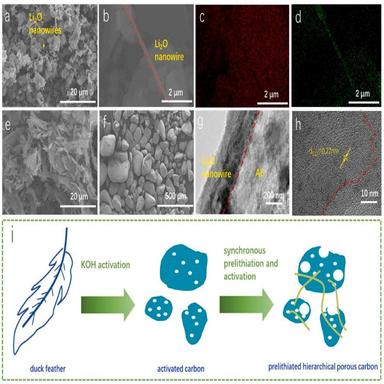
(a, b) SEM images of prAC, EDS spectrum for (c) carbon and (d) oxygen elements of prAC, SEM image of Li2C2O4 decomposed (e) with graphene and (f) without carbon source, (g and h) HRTEM images of prAC, and (i) schematic illustration of prAC preparation. SEM: scanning electron microscopy; EDS: energy dispersive spectroscopy; HRTEM: high-resolution transmission electron microscopy.